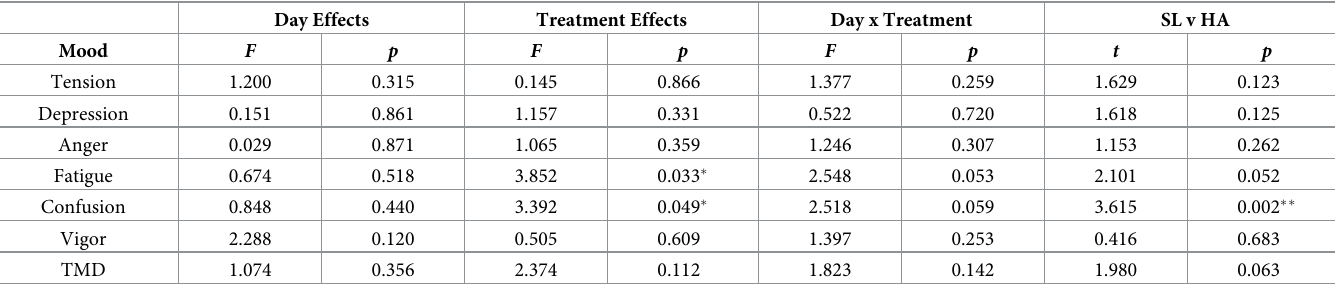
Table 1. Effects of altitude and sleep treatment on mood states described by POMS-A.